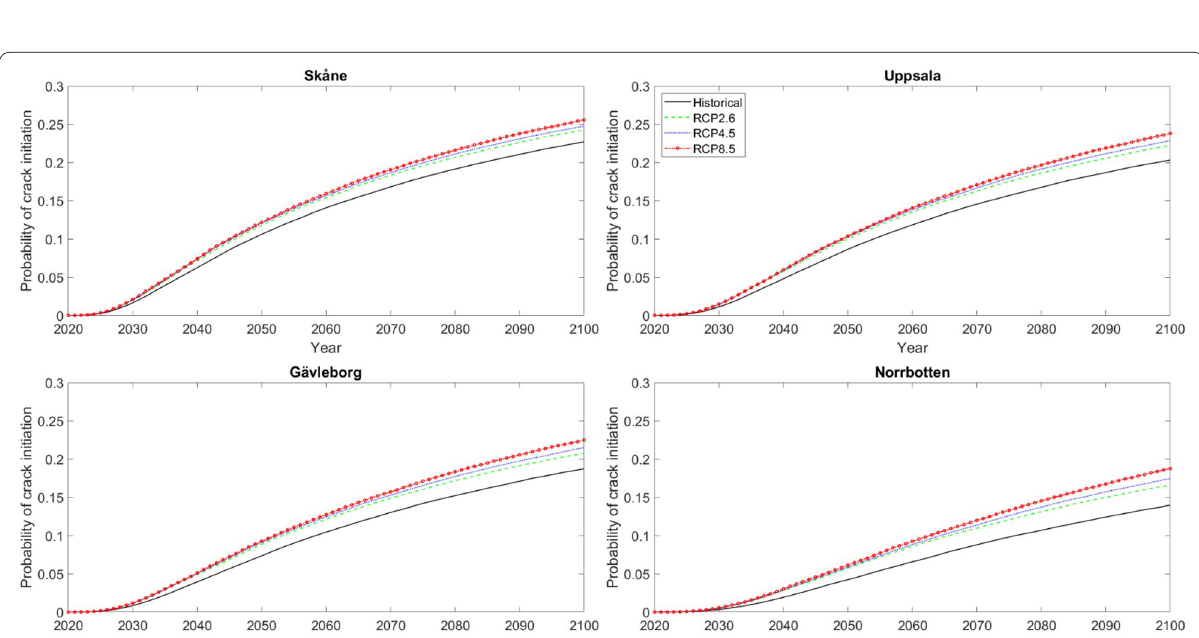
Fig. 5 Probability of corrosion initiation for the studied beam under the historical (1961 – 1990) and future climatic conditions for Skåne, Uppsala, Gävleborg, and Norrbotten